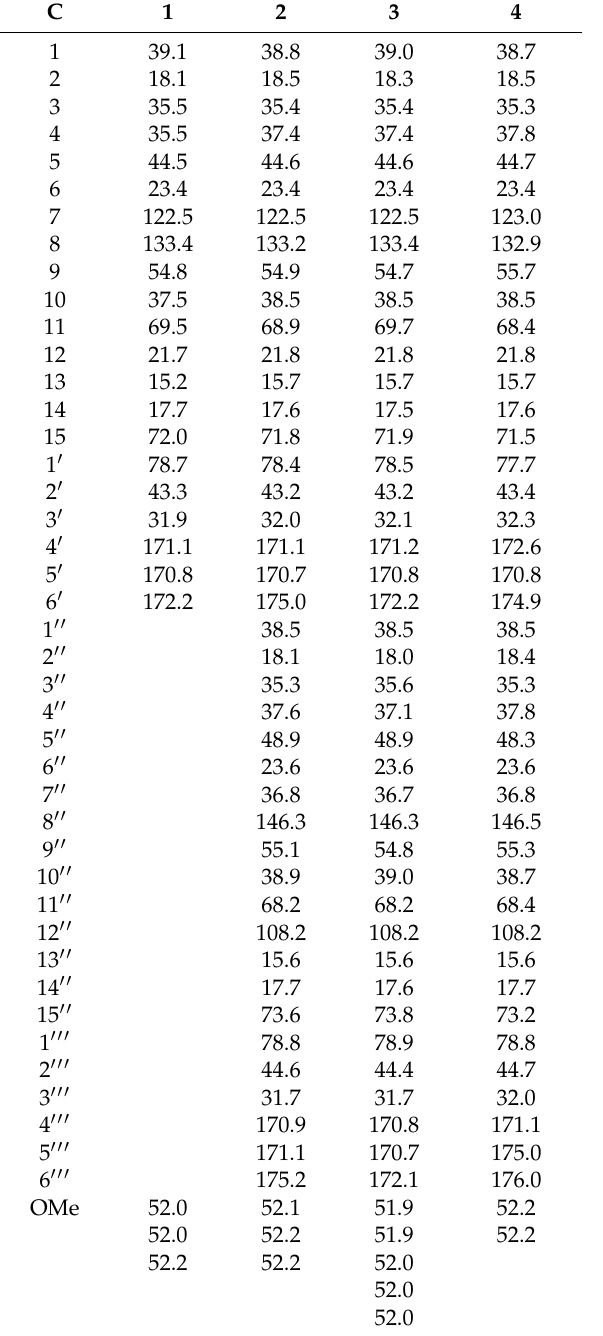
Table 2. The 13 C-NMR spectral data for compounds 1 – 4 (125 MHz, CDCl 3